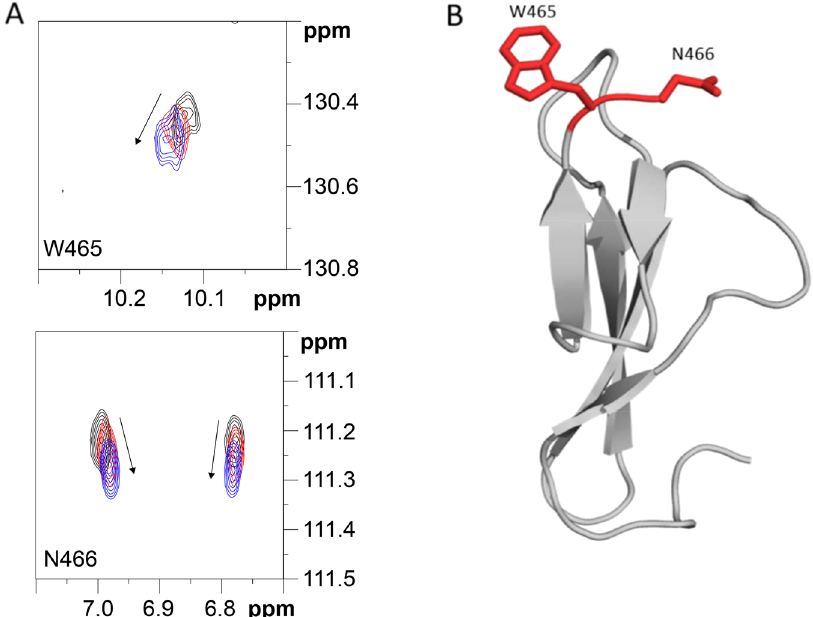
Figure 4. ChBD CHIT1-49 interaction with GlcNAc 3 and binding surface. ( A ) Overlay of an area of interest from the 15 N-HSQC spectrum for 0.20 mM ChBD CHIT1-49 in 50 mM phosphate buffer pH 7.0 recorded at 25 °C (black) in the presence of 4.5 mM (red) and 25 mM GlcNAc 3 (blue). The arrows indicate direction of the change in chemical shift upon titration. ( B ) The binding surface mapped on the structure of ChBD CHIT1-49 , where the side chain W465 and N466 are showed in red.